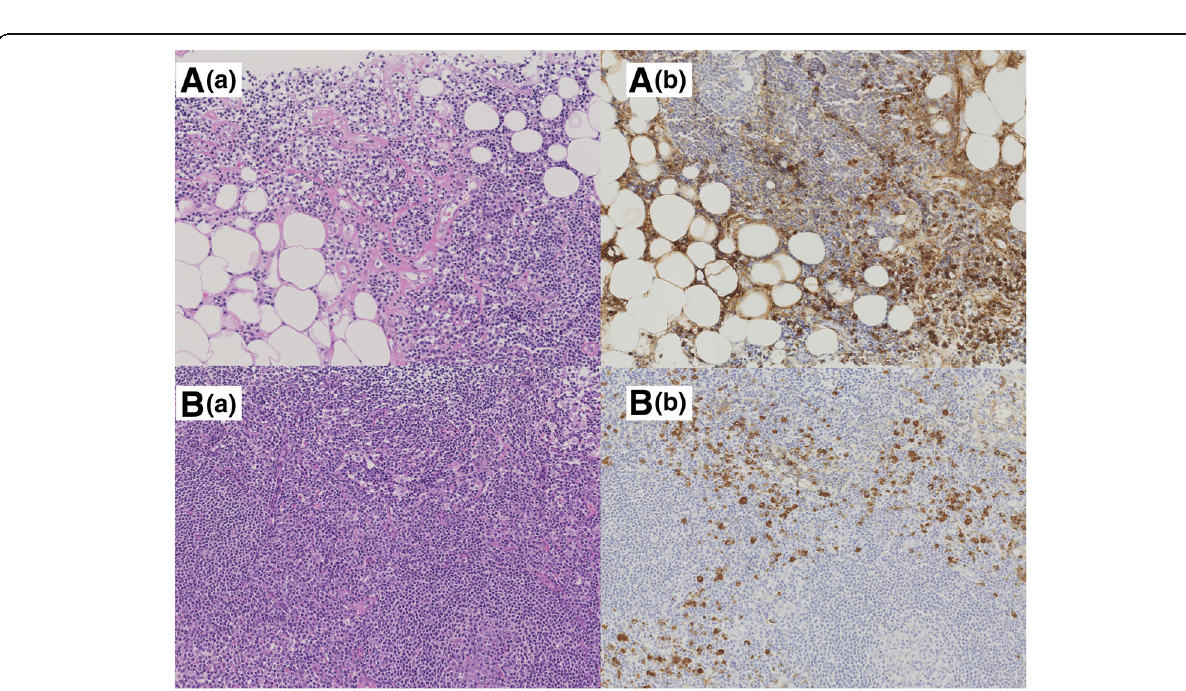
Fig. 4 Pathological findings from a core needle biopsy specimen after hematoxylin and eosin-staining and immunohistochemical staining for immunoglobulin (Ig) G4. a left breast. (a) Significant lymphocytic and plasma cell infiltration and interstitial fibrosis were observed. (b) More than 40% of the IgG-positive plasma cells were IgG4-positive. The mammary tissue contained almost no glandular component. b left axial lymph node. (a) Many plasma cells were observed in an expansive interfollicular area. (b) Many IgG4-positive plasma cells were